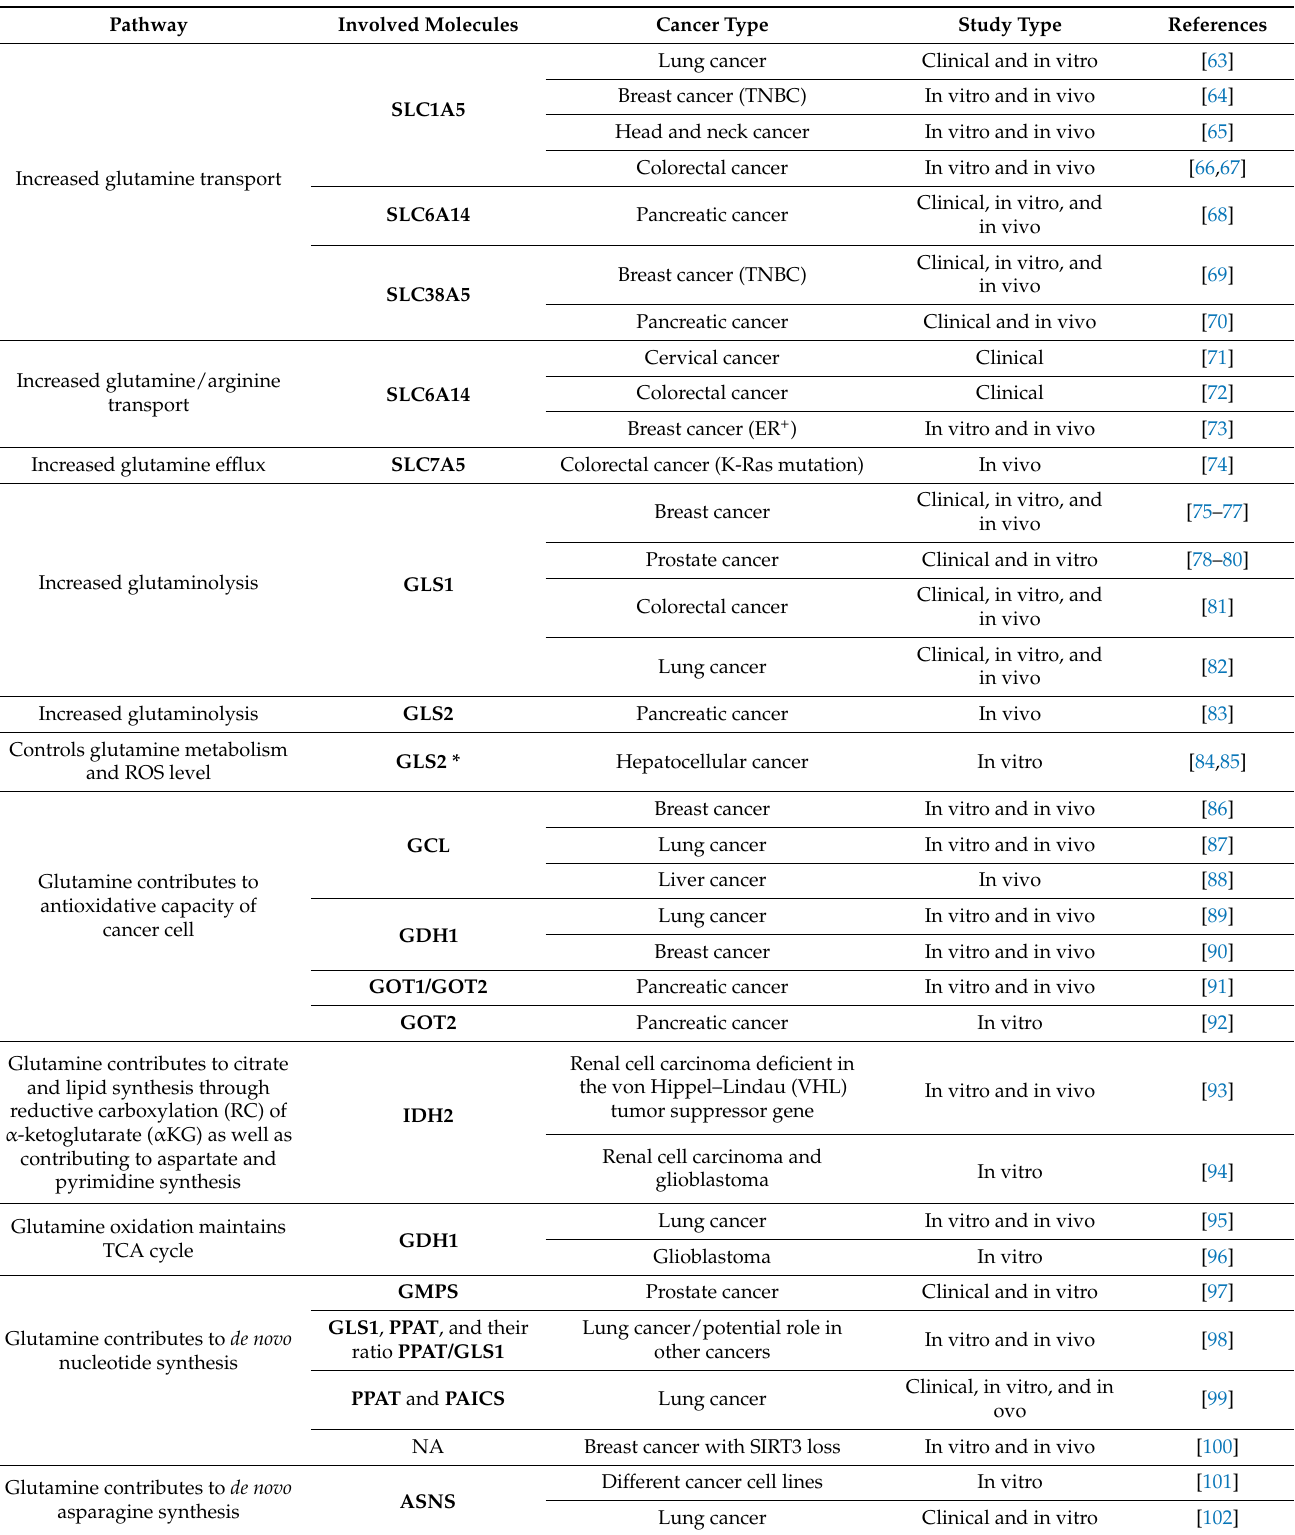
Table 1. An overview of metabolic fate of glutamine across different